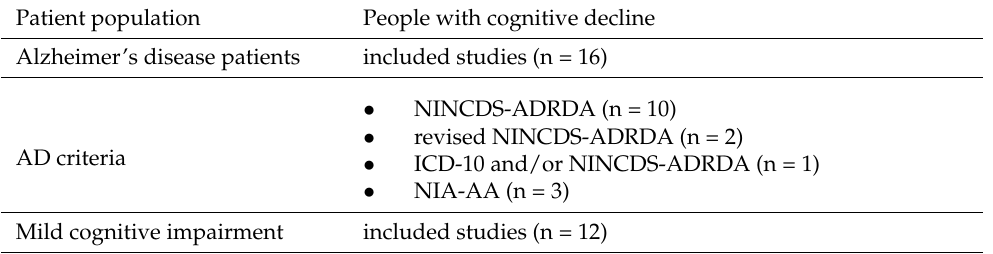
Table A1. Summary of